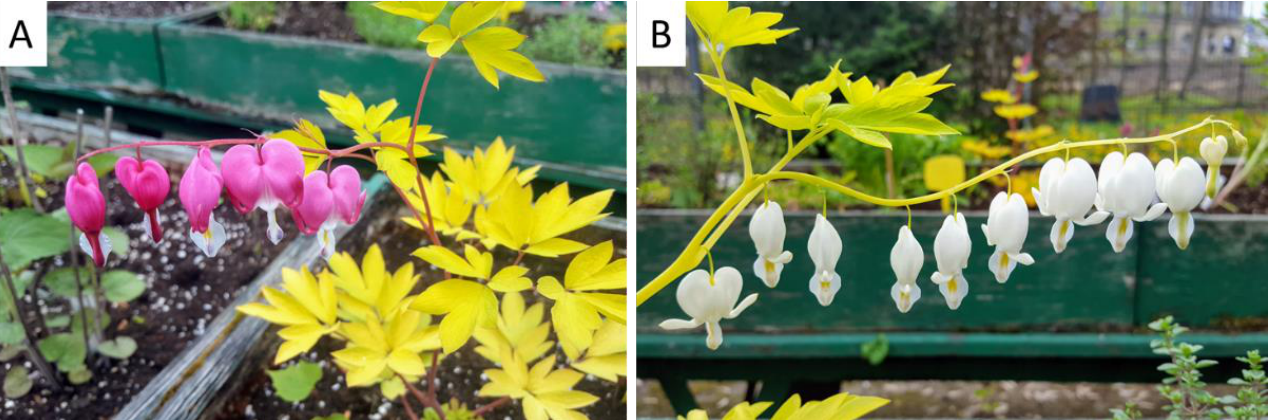
Figure 1. Lamprocapnos spectabilis (bleeding heart) ‘Gold Heart’ ( A ) and ‘White Gold’ ( B ).